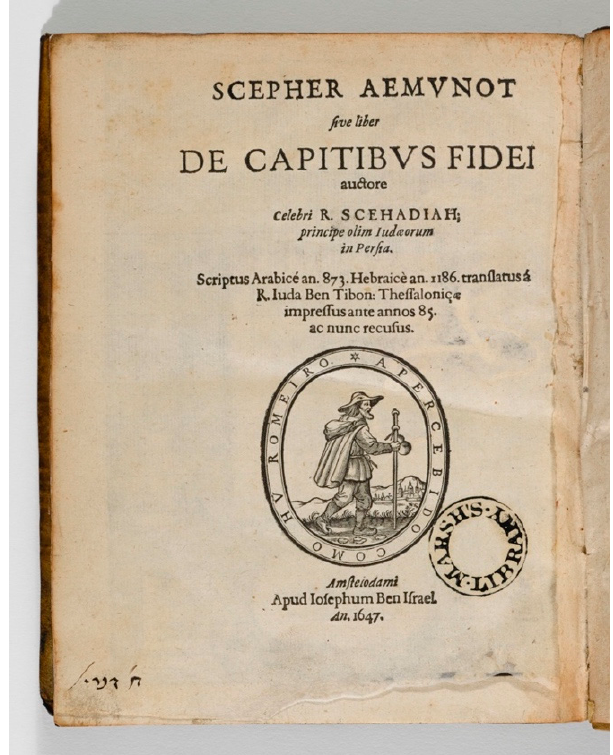
Figure 17. Latin title, Sefer emunot ve-de’ot (The Book of Beliefs and Opinions); Marsh’s Library B.3.4.9.